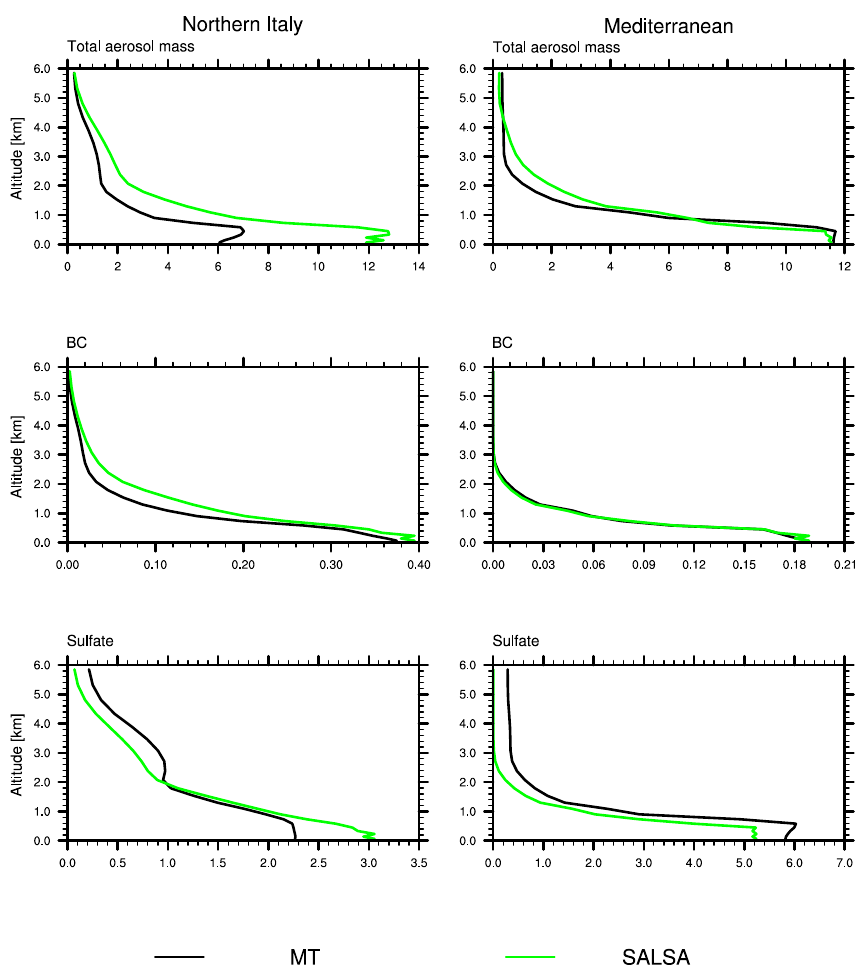
Figure 8. Vertical distribution of aerosol particles in northern Italy and over the Mediterranean on 22 June 2007 at